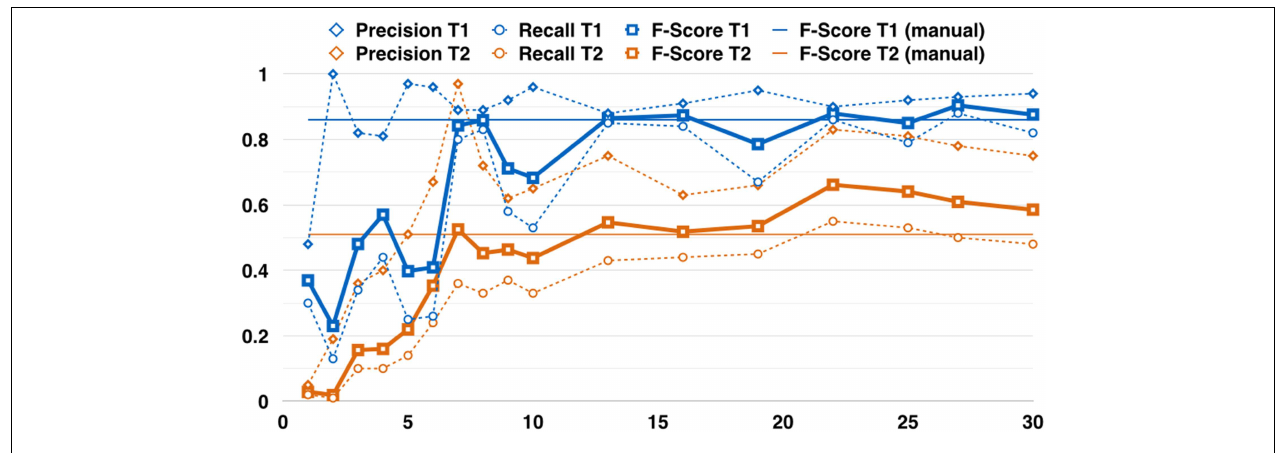
the precision (diamonds) and the recall (circles). The bold lines show the F-Score (squares). The thin straight lines indicate the detection performance for a manually tuned detection system for each individual transect (before DELPHI was established). These are horizontal lines as they represent the performance regarding the final tuned parameters for all images, rather than for a training set of increasing